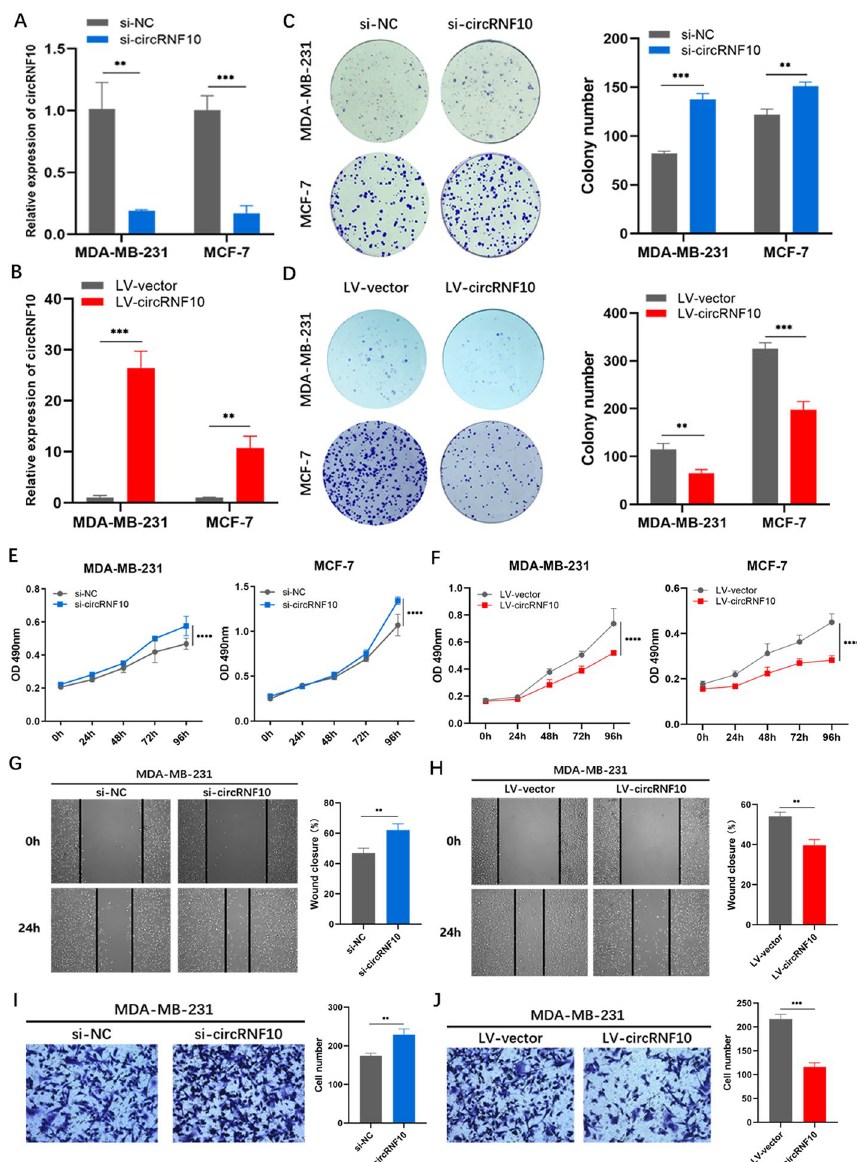
Fig. 2 CircRNF10 was a tumor suppressor in BC cells. A RT-qPCR analysis of si-circRNF10 efficiency in BC cells. B RT-qPCR analysis of lentivirus (LV)-circRNF10 efficiency in BC cells. C Colony formation assay performed in si-NC and si-circRNF10 groups to evaluate the effect of inhibiting circRNF10 in BC cells (left) and the statistics of colony numbers (right). D Colony formation assay performed in LV-vector and LV-circRNF10 groups to evaluate the effect of overexpressing circRNF10 in BC cells (left) and the statistics of colony numbers (right). E MTT assay showing the proliferation of BC cells in si-NC and si-circRNF10 groups. F MTT assay showing the proliferation of BC cells in LV-vector and LV-circRNF10 groups. G Wound-healing assay comparing the migration of MDA-MB-231 cells in si-circRNF10 group with control (left) and the statistics of wound closure percentage (right). H Wound-healing assay comparing the migration of MDA-MB-231 cells in LV-circRNF10 group with control (left) and the statistics of wound closure percentage (right). I Transwell assay showing the migration of MDA-MB-231 cells transfected with si-NC or si-circRNF10 (left) and the number of migrated cells (right). J Transwell assay showing the migration of MDA-MB-231 cells expressing LV-vector or LV-circRNF10 (left) and the number of migrated cells (right). Error bars represent the means SD. * P < 0.05, ** P < 0.01, ± *** P < 0.001, **** P <